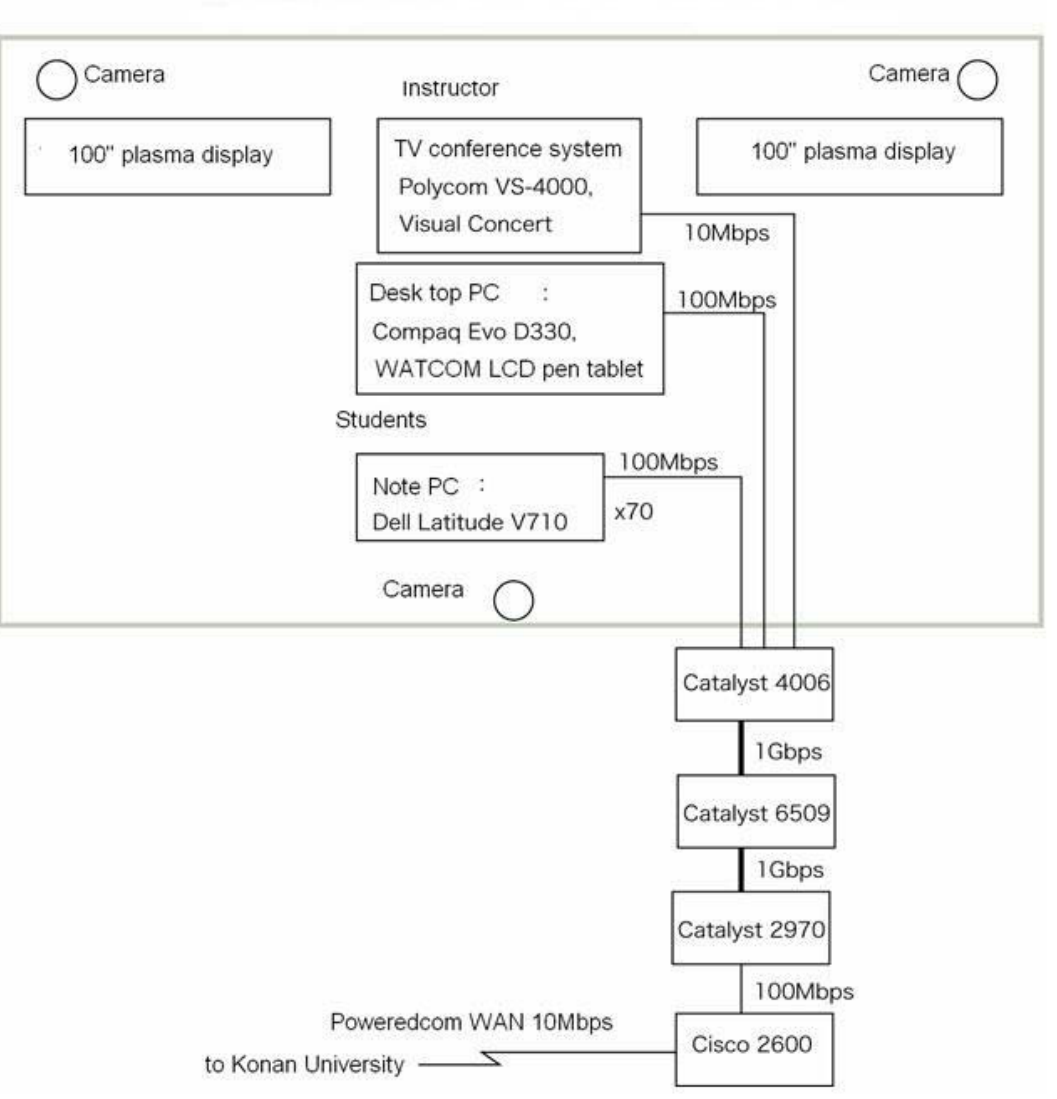
Figure 1. System Chart of Musashi University's 8501